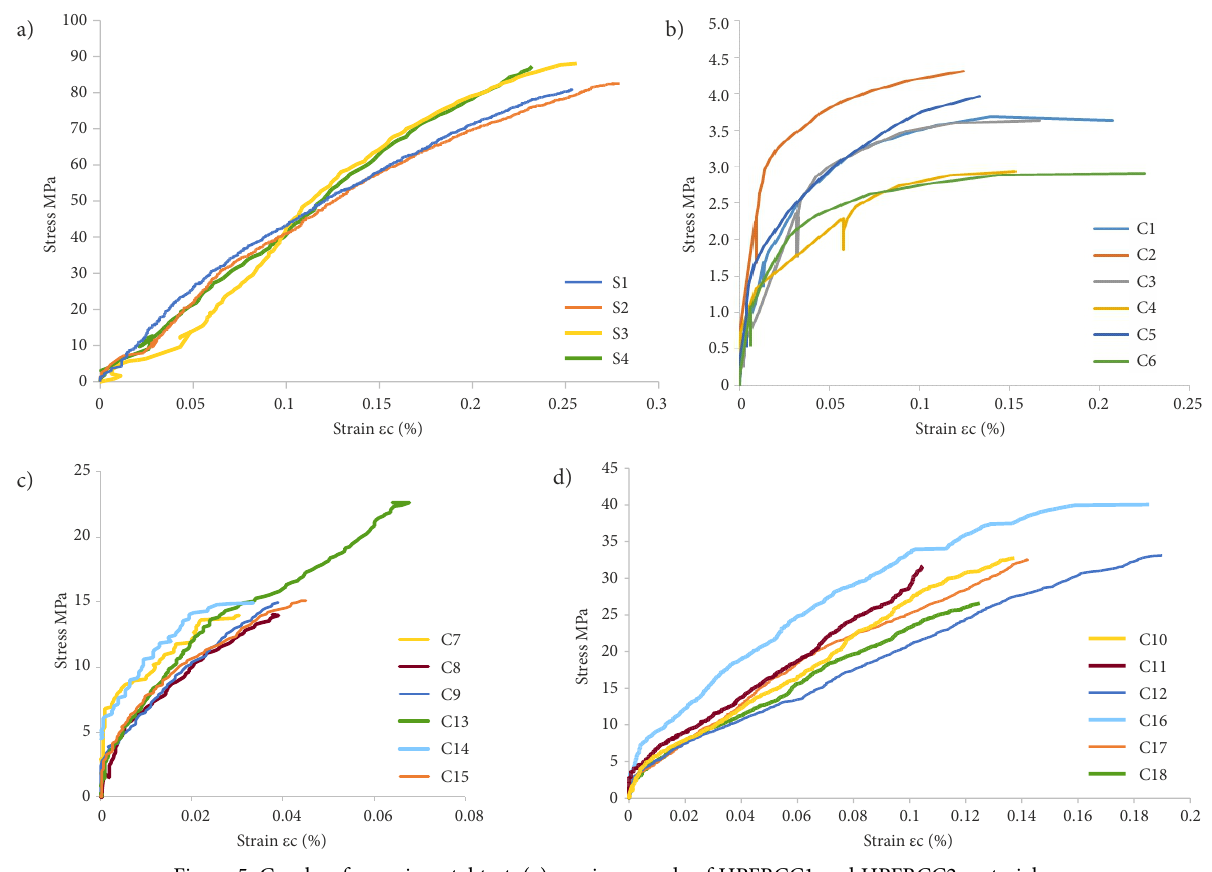
Figure 5. Graphs of experimental test: (a) – prisms made of HPFRCC1 and HPFRCC2 material; (b) – concrete cylinders; (c) – confined specimens; (d) – specimens loaded on whole surface